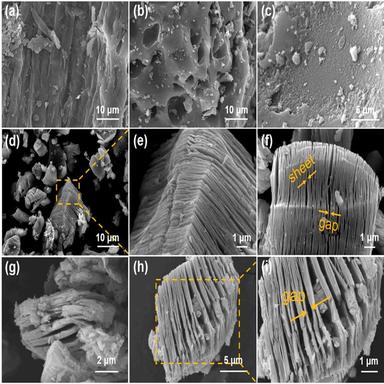
SEM images of (a) PAW, (b–c) BAC, (d–f) MXene and (g–i) CMAC.